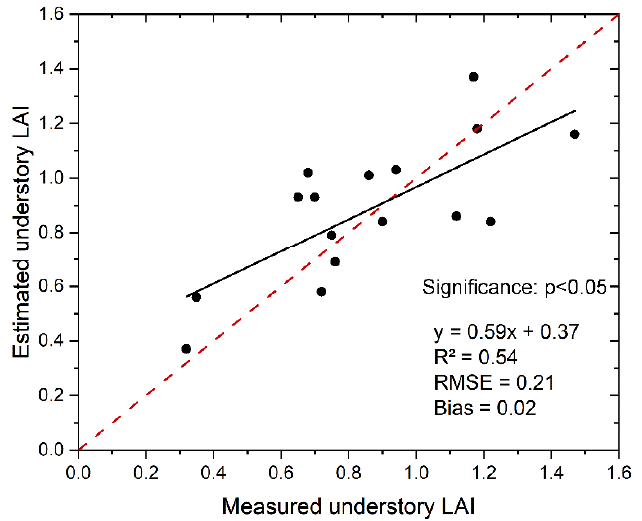
Figure 9. Plot-scale estimated understory LAI values versus measured understory LAI values.